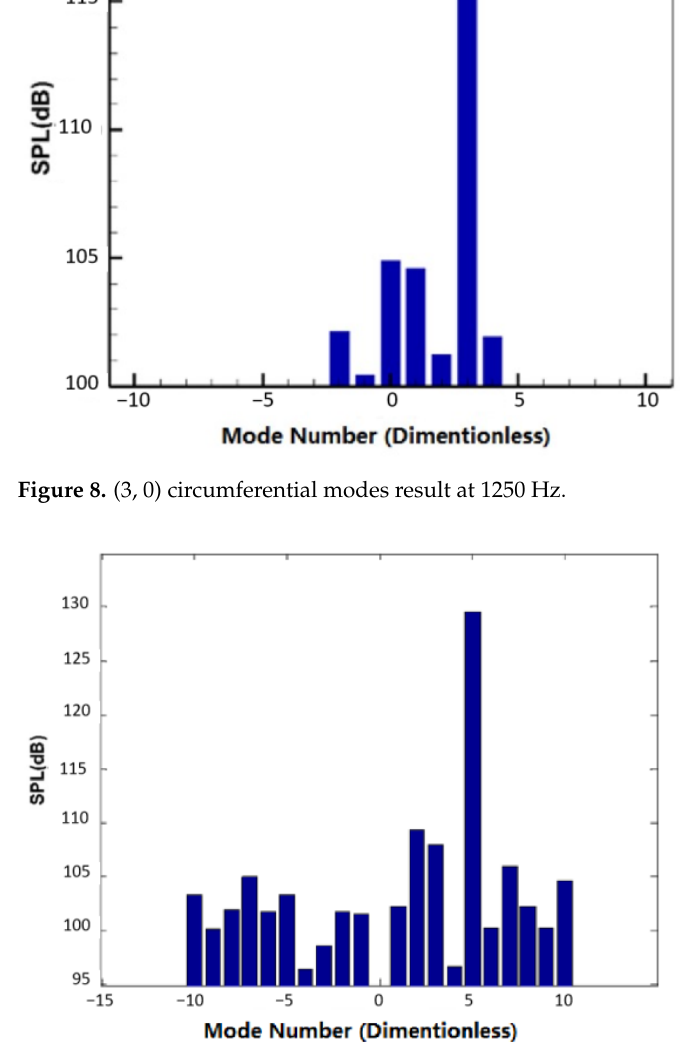
Figure 9. (5, 0) circumferential modes result at 2000 Hz.